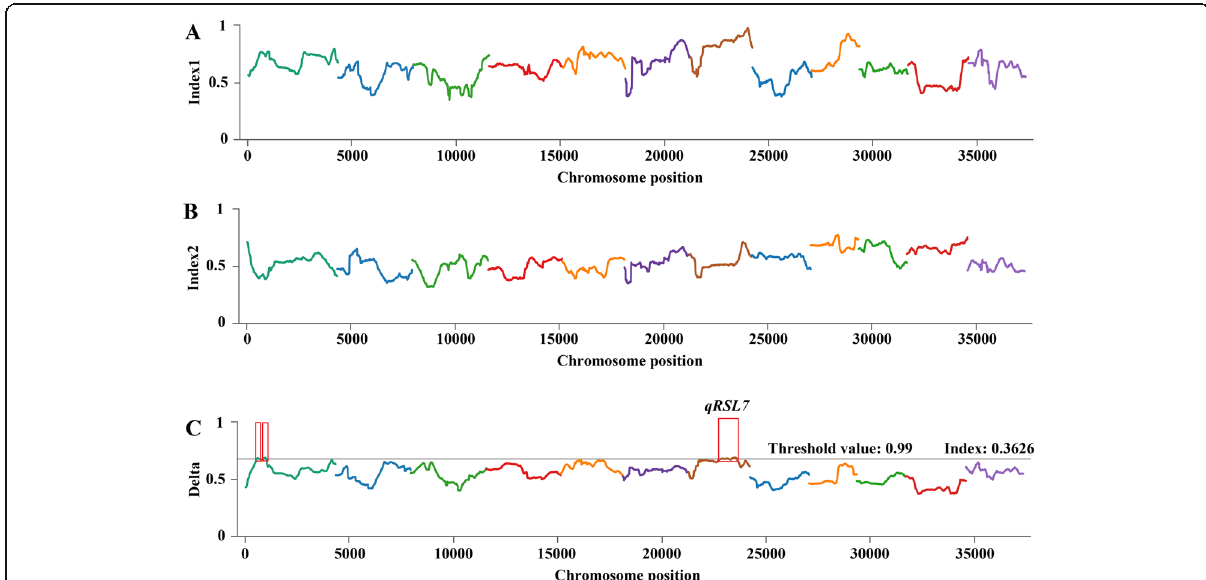
Fig. 4 Δ SNP-index algorithm mapping salt-tolerant QTL. X-axis represents the position of 12 chromosomes of rice and Y-axis represents the SNP- index or Δ SNP-index. The different colour lines show the SNP-index or Δ SNP-index value of fitting results in 12 chromosomes. a The SNP-index